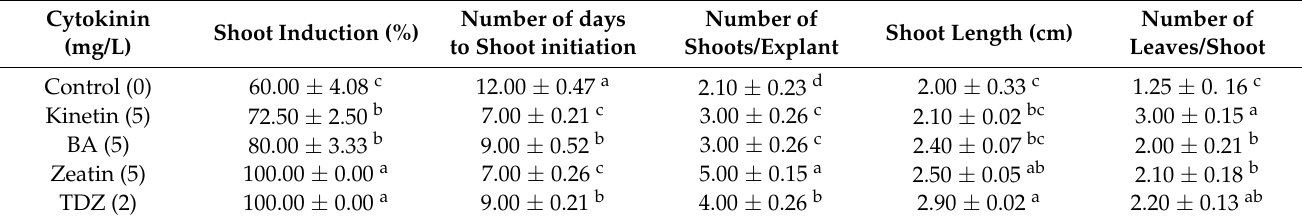
Table 3. Effects of different types of cytokinins on shoot organogenesis from the callus explant of the feverfew